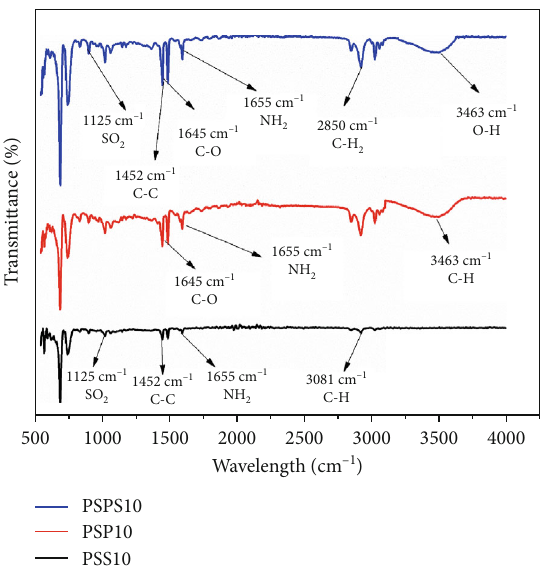
Figure 2: FTIR spectra of PSPS10, PSP10, and